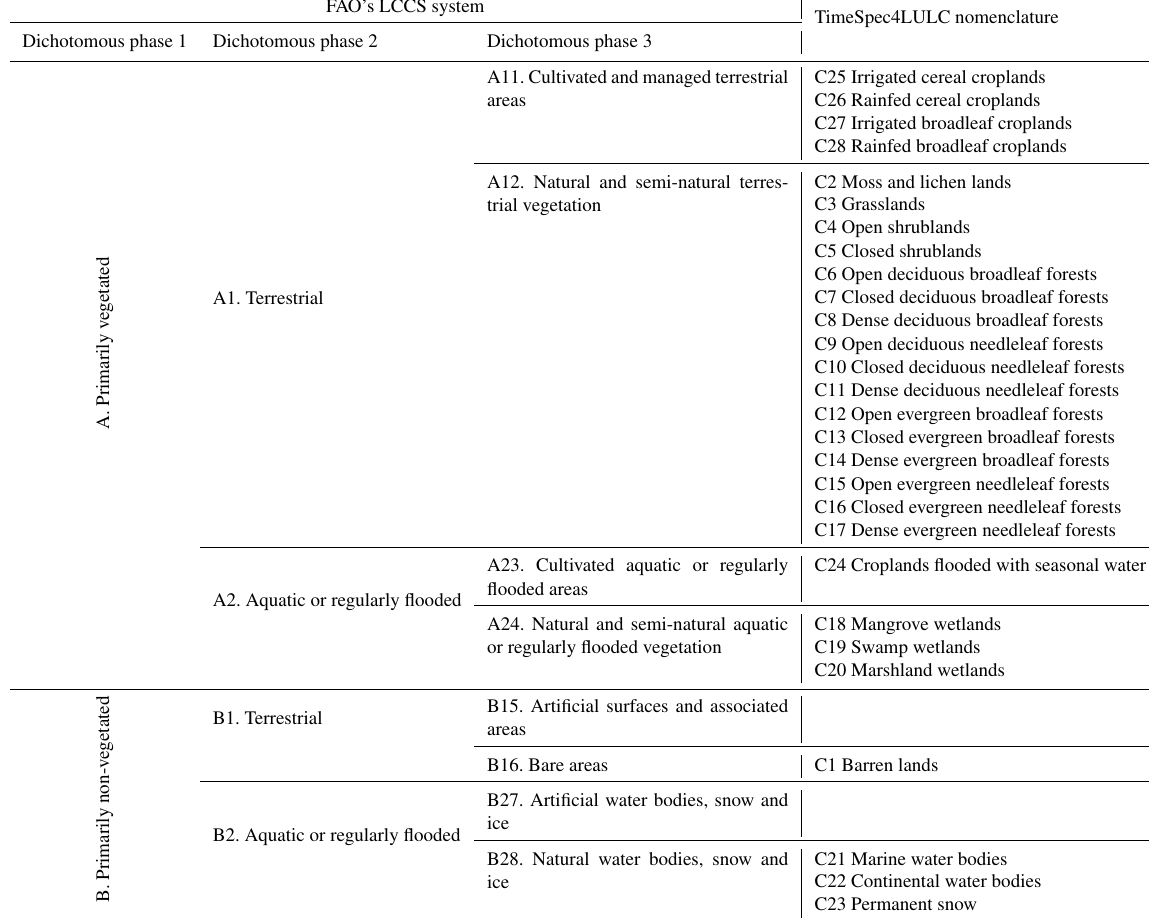
Table A1. Translation of TimeSpec4LULC legend to FAO’s Land Cover Classification System